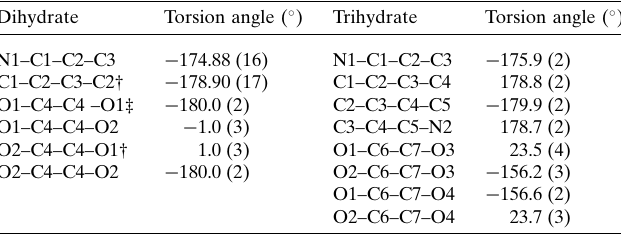
Table 2 Comparison of the torsion angle data for the dihydrate and trihydrate. Dihydrate Torsion angle ( (cid:3) ) Trihydrate Torsion angle ( (cid:3)